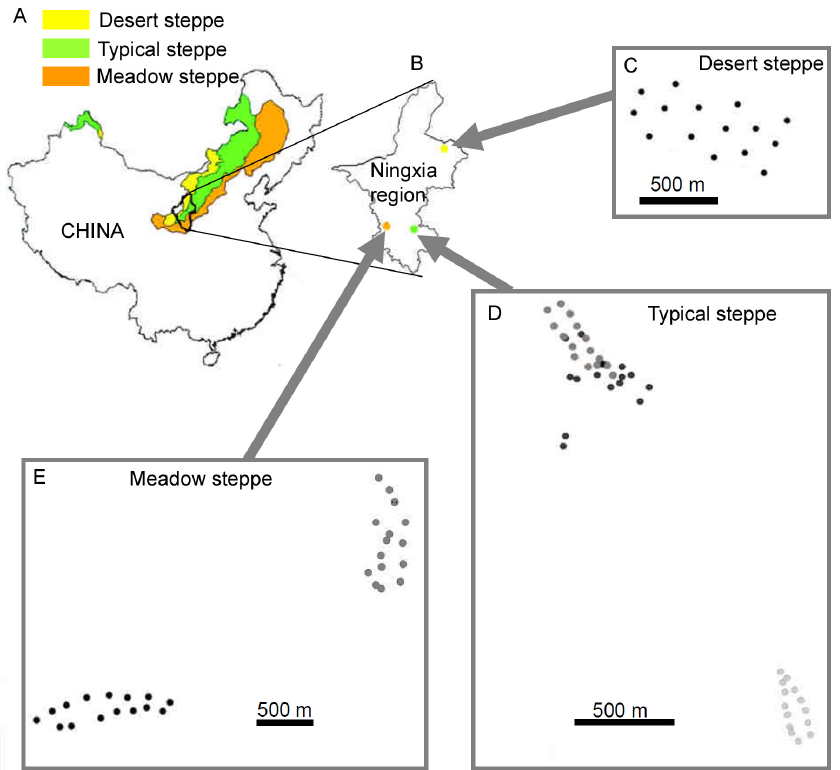
Figure 1. Study area and sampling sites: ( A ) distribution in China of the three grassland types investigated in the present research (redrawn from Kang et al. [29]); ( B ) location of the three study areas, representative of the three grassland types, in the Ningxia region; ( C – E ) distribution of sampling sites. Dots of di ff erent colors within the same panel indicate that they belong to di ff erent sectors (identified on vegetation). Due to relief, some sampling sites may appear closer than they were in the reality.